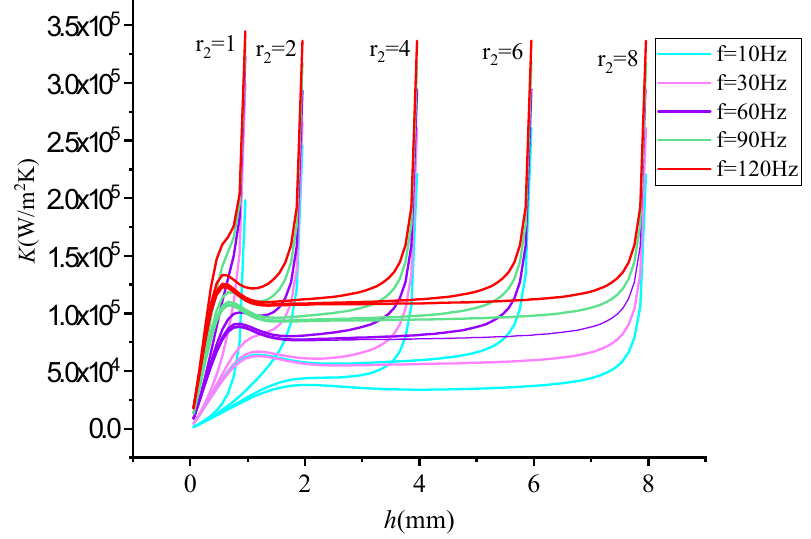
Figure 12. Heat transfer coefficient K of different ultimate wall thickness r 2 .